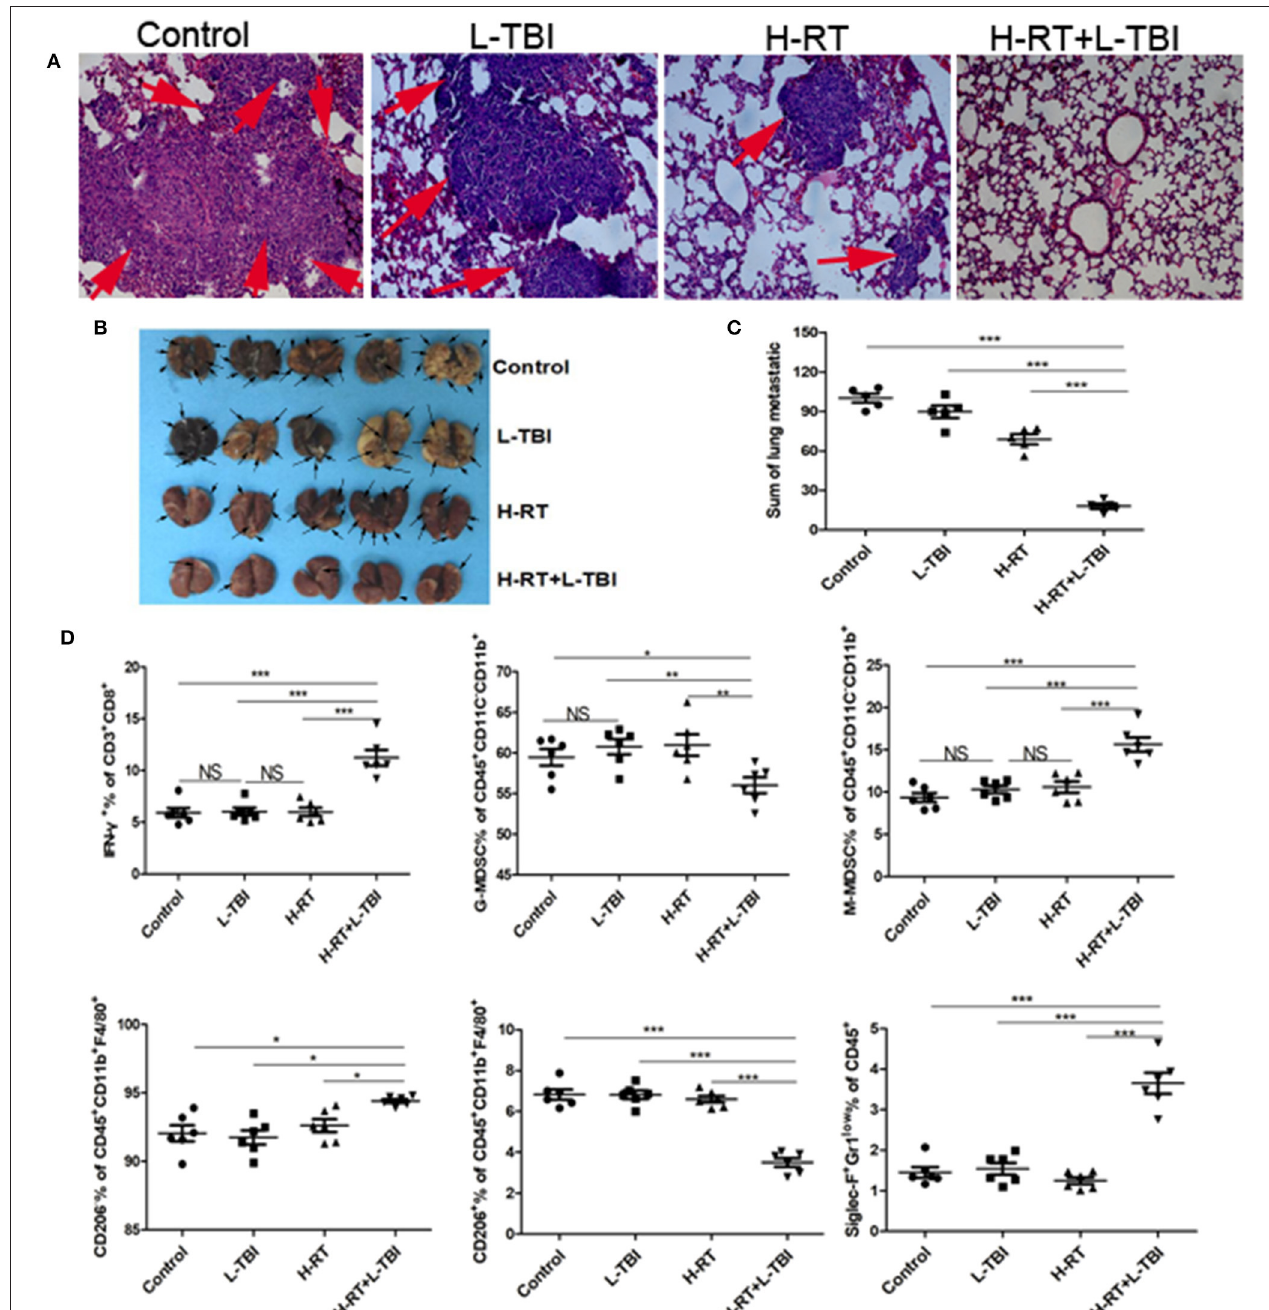
FIGURE 7 | Anti-metastatic effect of the H-RT and L-TBI combination therapy. (A) Comparison of representative H&E-stained in lung tissue sections at 24 days after 4T1 cells implantation (original magnification × 100). The arrows point to the metastatic infiltration. (B) Representative macroscopic images of the lungs in different groups. The arrows point to the metastatic nodules in the lung ( n = 5 mice/group). (C) Comparison of the lung metastatic nodules between control, L-TBI, H-RT, and H-RT + L-TBI group ( n = 5 mice/group). (D) Frequency of IFN- γ + CD8 + T cells (CD3 + CD8 + IFN- γ + ), G-MDSC (CD45 + CD11c − CD11b + Ly6G + Ly6c low ), M-MDSC (CD45 + CD11c − CD11b + Ly6G − Ly6c hi ), M1 (CD45 + CD11b + F4/80 + CD206 − ), M2 (CD45 + CD11b + F4/80 + CD206 + ), and Eosinophils (CD45 + Siglec-F + Gr1 low ) in mice spleens ( n = 6 mice/group). Data are representative charts or the percentages of individual subjects. Data are expressed as mean ± SE. In general, combined therapy of H-RT + L-TBI significantly reduced the number and diameter of lung metastatic nodules ( P < 0.001). (* P < 0.05, ** P < 0.01, *** P < 0.001, NS = not significant).